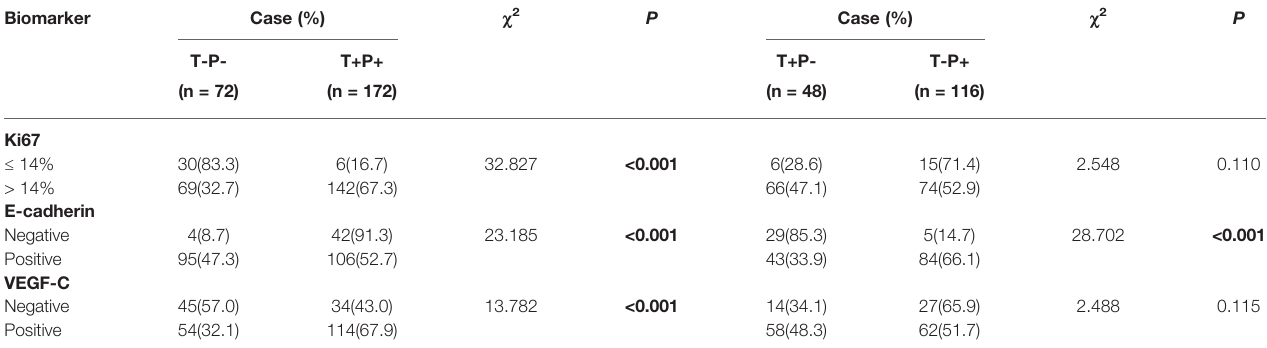
TABLE 4 | Correlations of mutant p53 and Twist1 expression with other molecules in breast cancer patients.